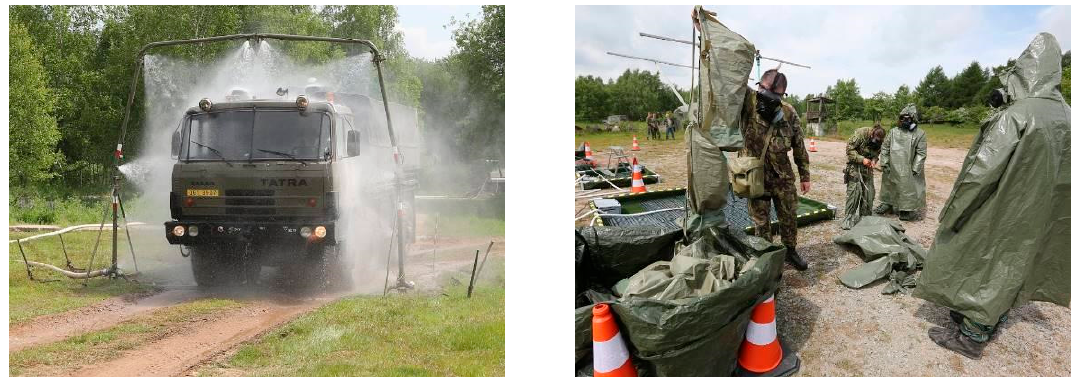
Figure 1. Examples of the decontamination site [15].